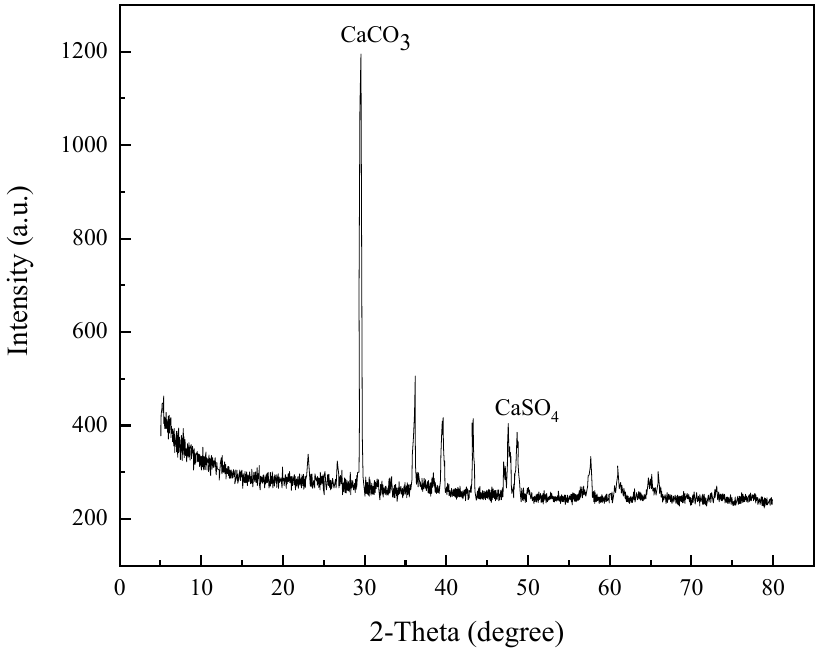
Figure 5. Mineralogical characterization result of representative solid sediments.